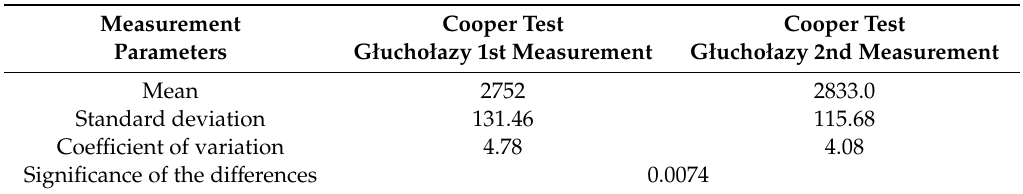
Table 5. The values of the stamina and performance parameters of the football players in the 1st and 2nd measurements in Głuchołazy.